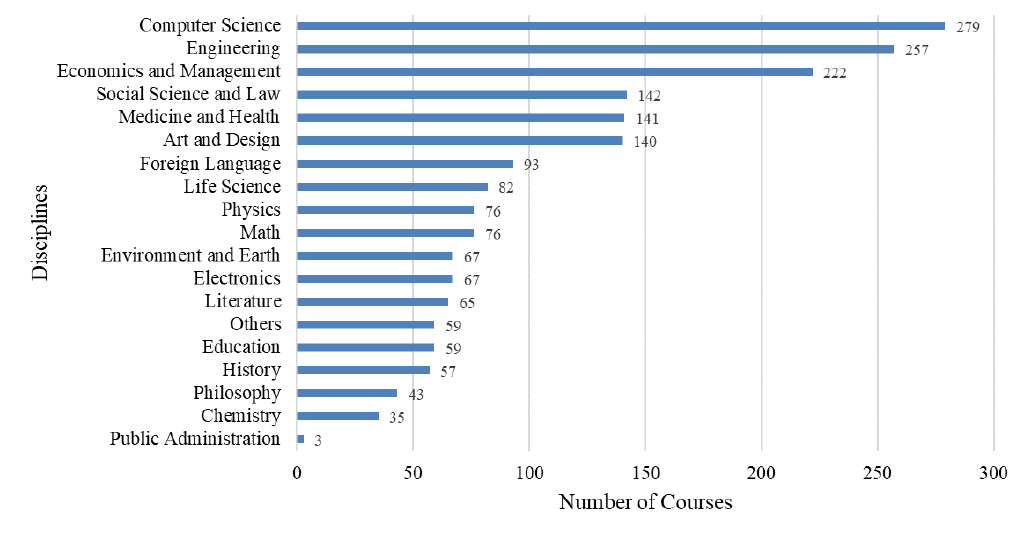
Figure 2 Number of Courses Within Each of the 19 Disciplines on